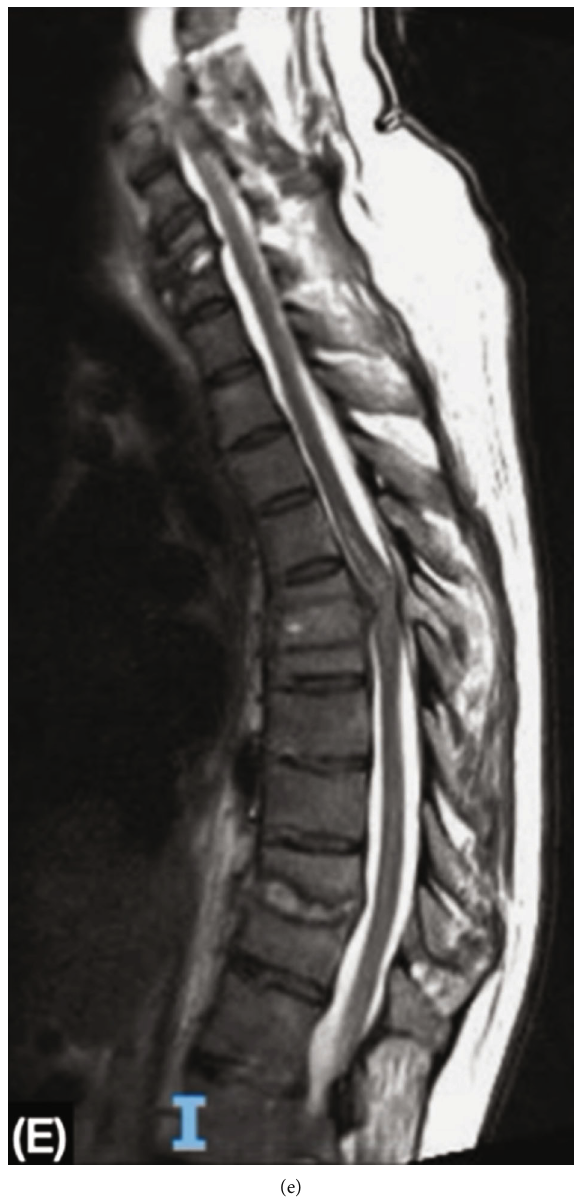
Figure 1: MRI showing the cervical, thoracic, and lumbar spine. (a, b) At the cervical spine, loss of the lordotic angle is demonstrated; destruction of the 6th cervical vertebrae is noted. In C3-C4, there is a collapse of the disc with changes in the signal intensity of the vertebral endplates, which are hyperintense in STIR T2 and isointense in T1 as well as an epidural abscess of 27 × 4 : 5 mm and encompasses the entire topography of C3 and C4, displacing and compressing the spinal cord. (c, d) At the level of the T12 and L1 vertebral bodies, respectively, in their lower and upper endplates, there is an erosive lesion of 17 × 18 mm involving the intervertebral disc, hyperintense on T2, and hypointense on T1, presenting wall enhancement following contrast. (e) The morphology and height of vertebral bodies T6 and T7 presented morphology alterations due to the destruction of the lower and upper vertebral endplates, respectively, associated with an expansive mass including the intervertebral disc, noted as hypointense on T1 and enhanced on T1 FatSat with gadolinium, and these changes are also observed in the epidural space, surrounding the spinal